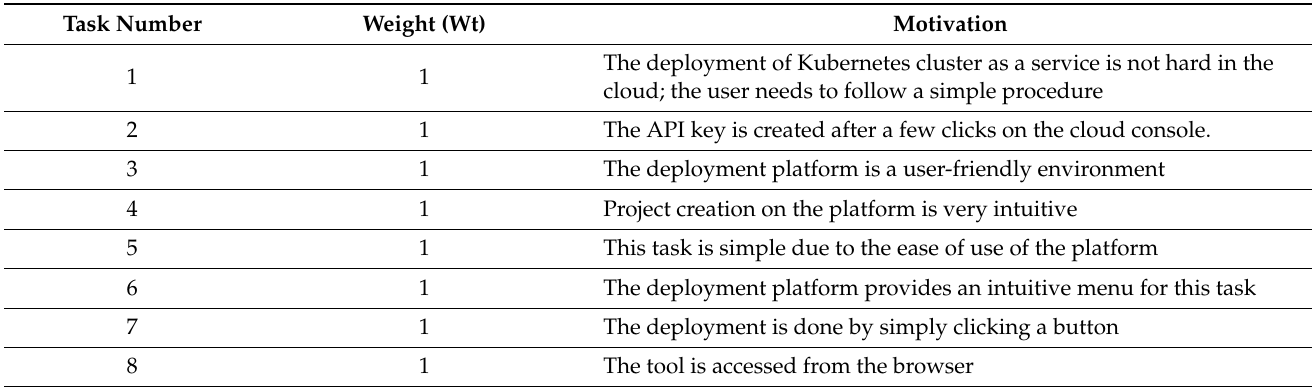
Table 9. Weights for the automated deployment tasks.